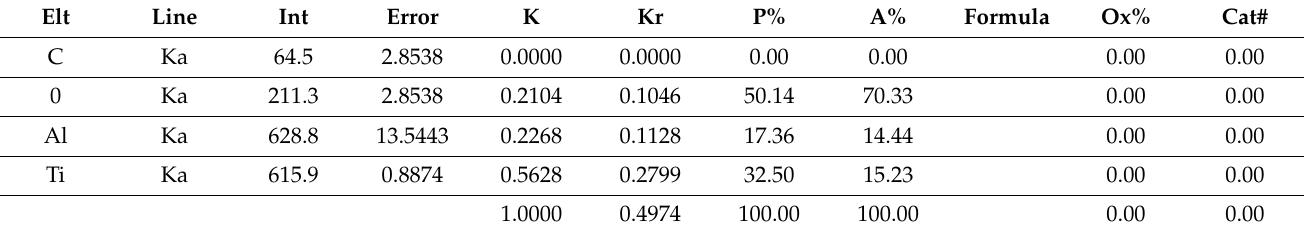
Table 6. The quantitative results of the EDS analysis of the Inkone ® implant demonstrating weight Table 5. The quantitative results of the EDS analysis of the Straumann implant’s neck demonstrating weight percentages (P%) and atomic percentages (A%) of the elements detected [15].